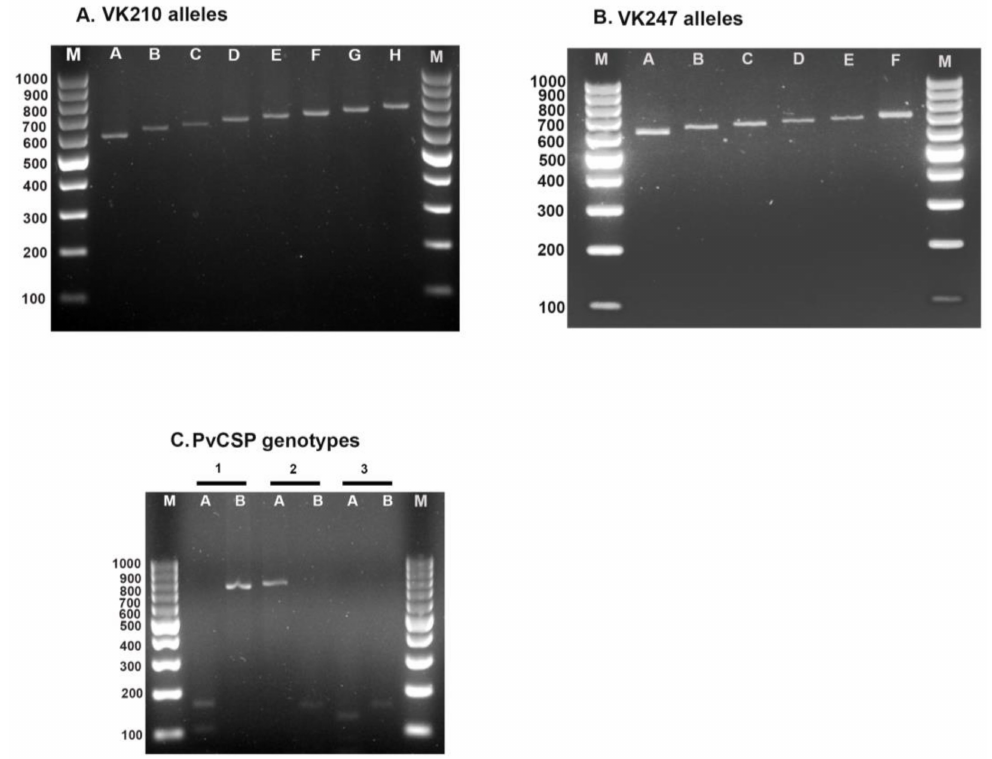
Figure 1. PCR product size variations and genotypes of PvCSP. Gel images depict: ( A ) PCR product size variations for VK210; ( B ) PCR product size variations for VK247; and ( C ) PvCSP products digested with AluI (A) and BstNI (B) enzymes. Sample No. 1: A cut the product into small fragments, but B did not cut the product (VK210 genotype). Sample No. 2: A did not cut the product into small fragments, but B cut the product (VK247 genotype). Sample No. 3: A and B cut the products into small fragments (mixed genotype). M: Molecular marker (100